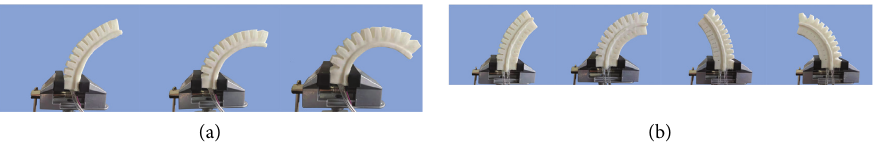
Figure 6: Motion process of pneumatic soft-bodied bionic basic execution unit. (a) Unidirectional basic execution unit. (b) Bidirectional basic execution unit.